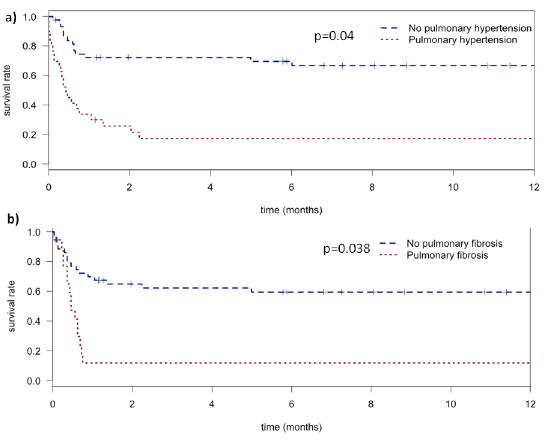
connective tissue disease-associated ILD or acute idiopathic interstitial pneumonia (Table 4). Three factors were independently associated with hospital